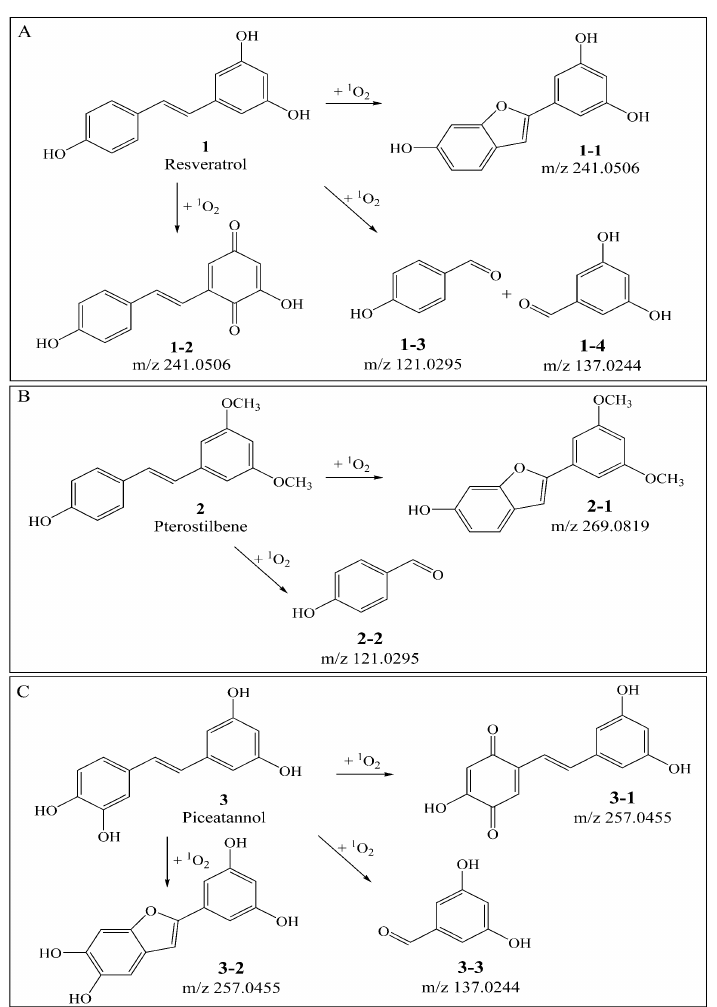
Figure 1. ( A ): Proposed mechanism of resveratrol quenching 1 O 2 ( 1 : resveratrol; 1-1 , 1-2 , 1-3 , 1-4 : proposed products of resveratrol against 1 O 2 ). ( B ): Proposed mechanism of pterostilbene quenching 1 O 2 ( 2 : pterostilbene; 2-1 , 2-2 : proposed products of pterostilbene against 1 O 2 ). ( C ): Proposed mechanism of piceatannol quenching 1 O 2 ( 3 : piceatannol; 3-1 , 3-2 , 3-3 : proposed products of piceatannol against 1 O 2 ).